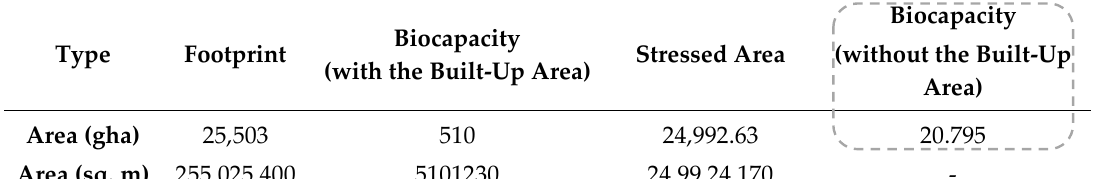
Table 7. Stress area delineation.